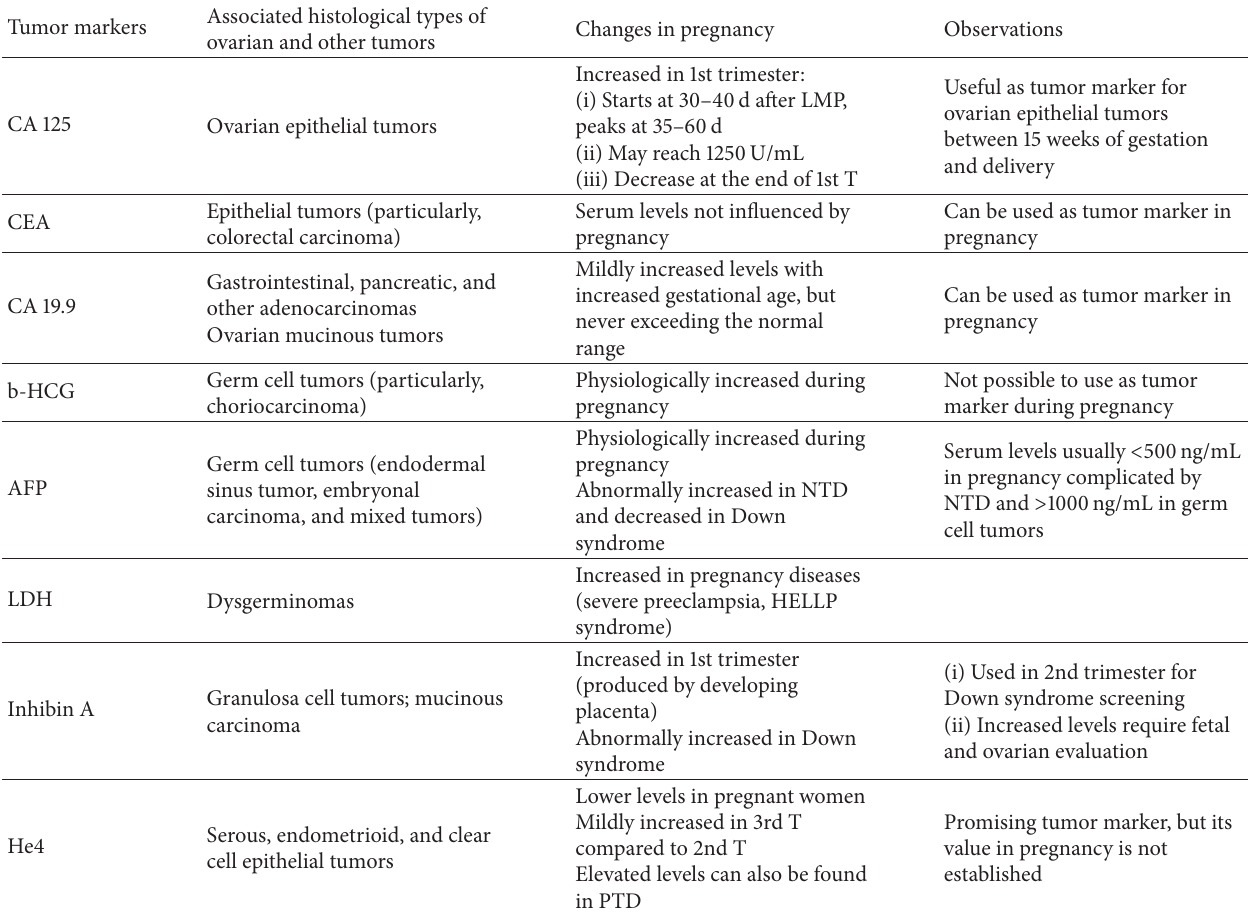
Table 4: Tumor markers in pregnancy [21–27].